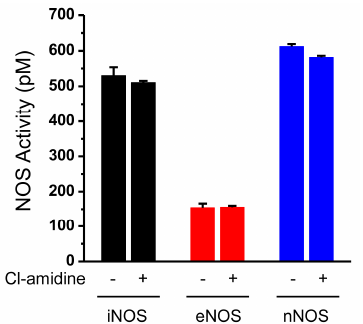
Figure 2. Cl-amidine does not directly inhibit NOS activity. Recombinant NOS (180 ng inducible NO synthase (iNOS); 210 ng endothelial NOS (eNOS); and 420 ng nNOS) was preincubated with or without Cl-amidine (200 µ M) for 1 h, and then activity was measured for 1 h. Quantitative levels are represented by bars (mean ± SD; n =